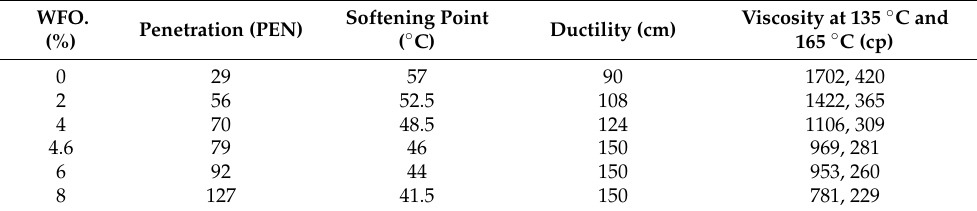
Table 4. Trials to determine the optimum waste frying oil content for the 40% RAPB. WFO.